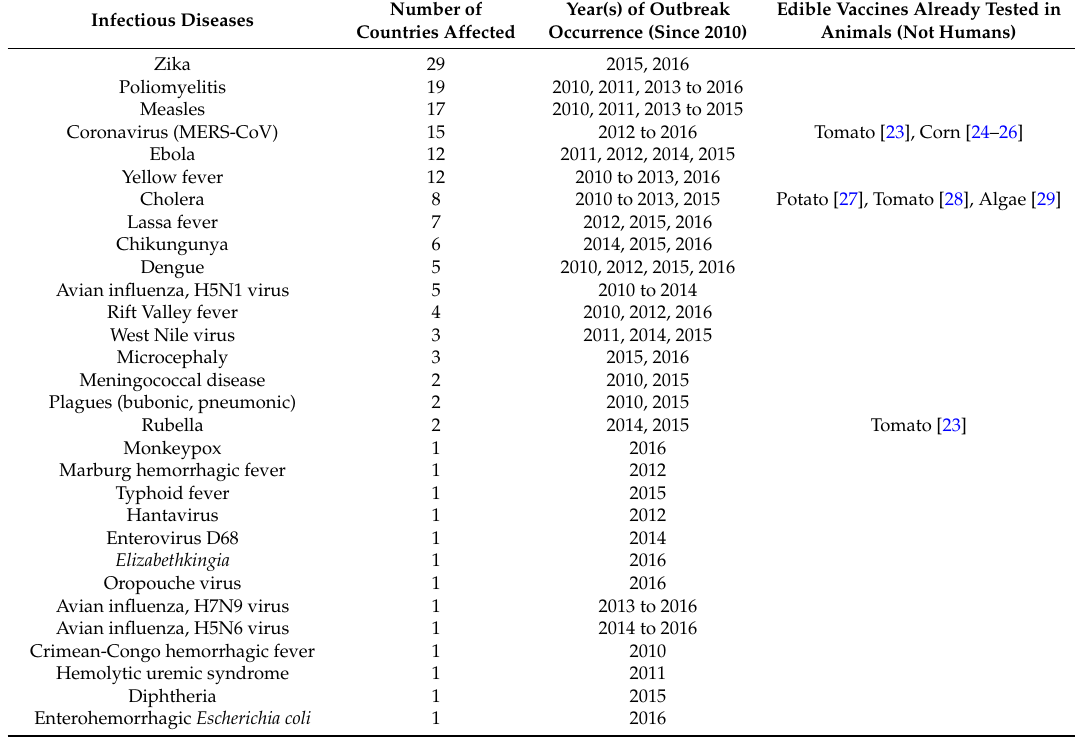
Onset of outbreak of infectious diseases around the world over the last six years (until September 2016) according the World Health Organization (WHO) [15–18]. Data are presented by continent, country, disease, and year of outbreak. Number of Year(s) of Outbreak Edible Vaccines Already Tested in Infectious Diseases Countries Affected Occurrence (Since 2010) Animals (Not